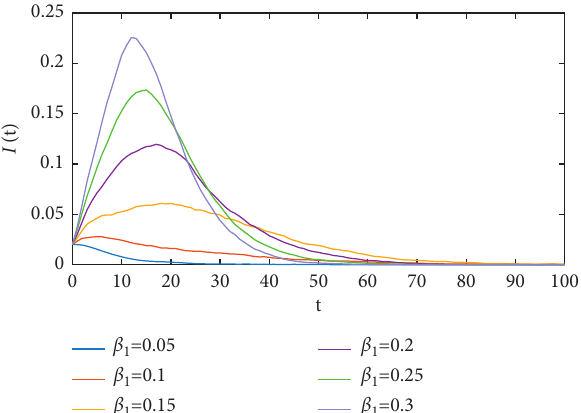
Figure 5: The density of infected individuals in the physical layer as a function of time for different epidemic transmission